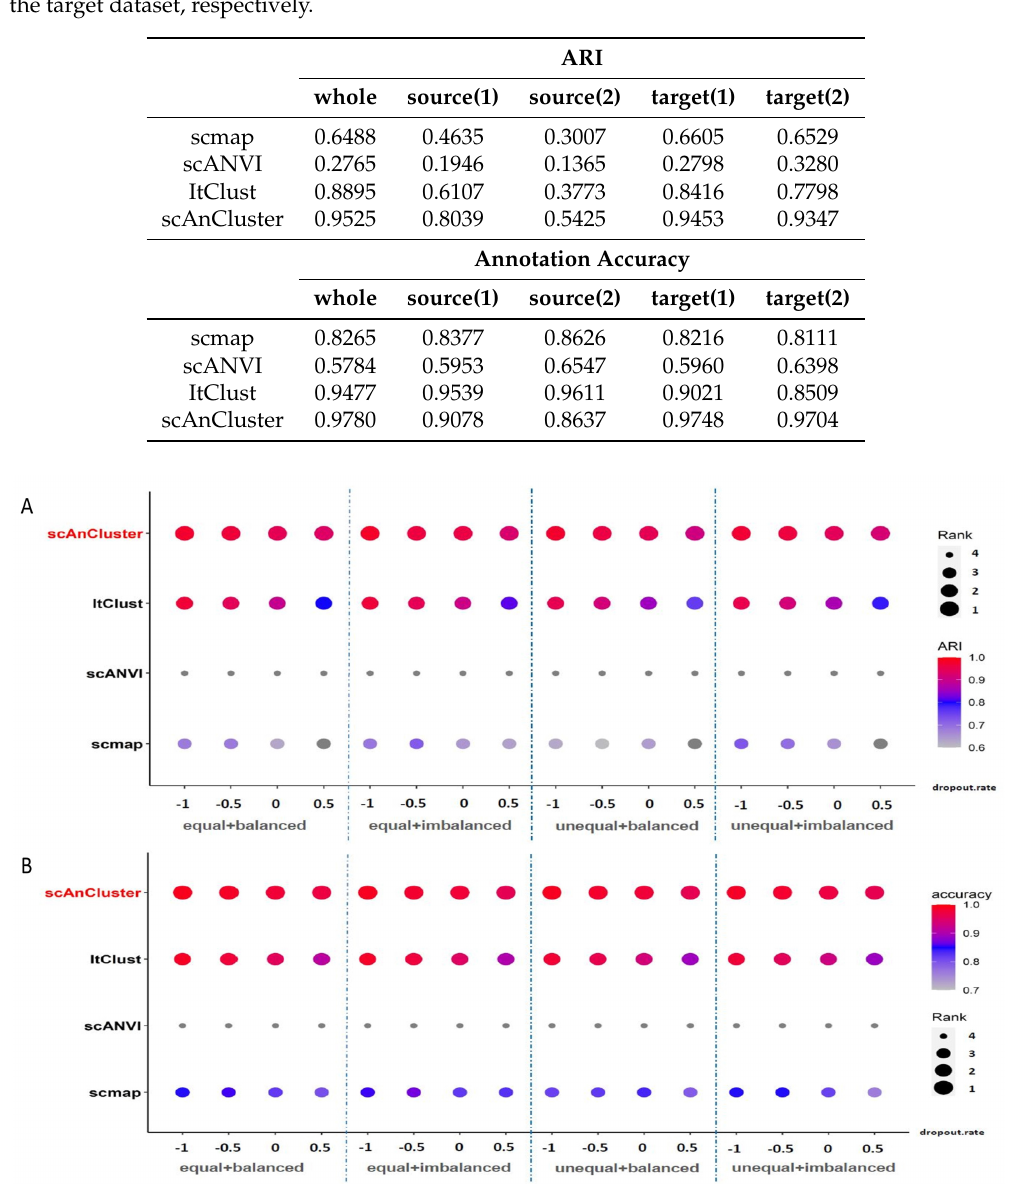
Table 2. Average performance of scmap, scANVI, ItClust and scAnCluster in 16 cases for different simulation settings. “Whole” refers to the experiments with complete data. “source(1)” and “source(2)” refer to the deletion of cell types with label {0} and label {0, 1} in the source dataset, respectively. Similarly, “target(1)” and “target(2)” refer to the deletion of cell types with label {0} and label {0, 1} in the target dataset, respectively.